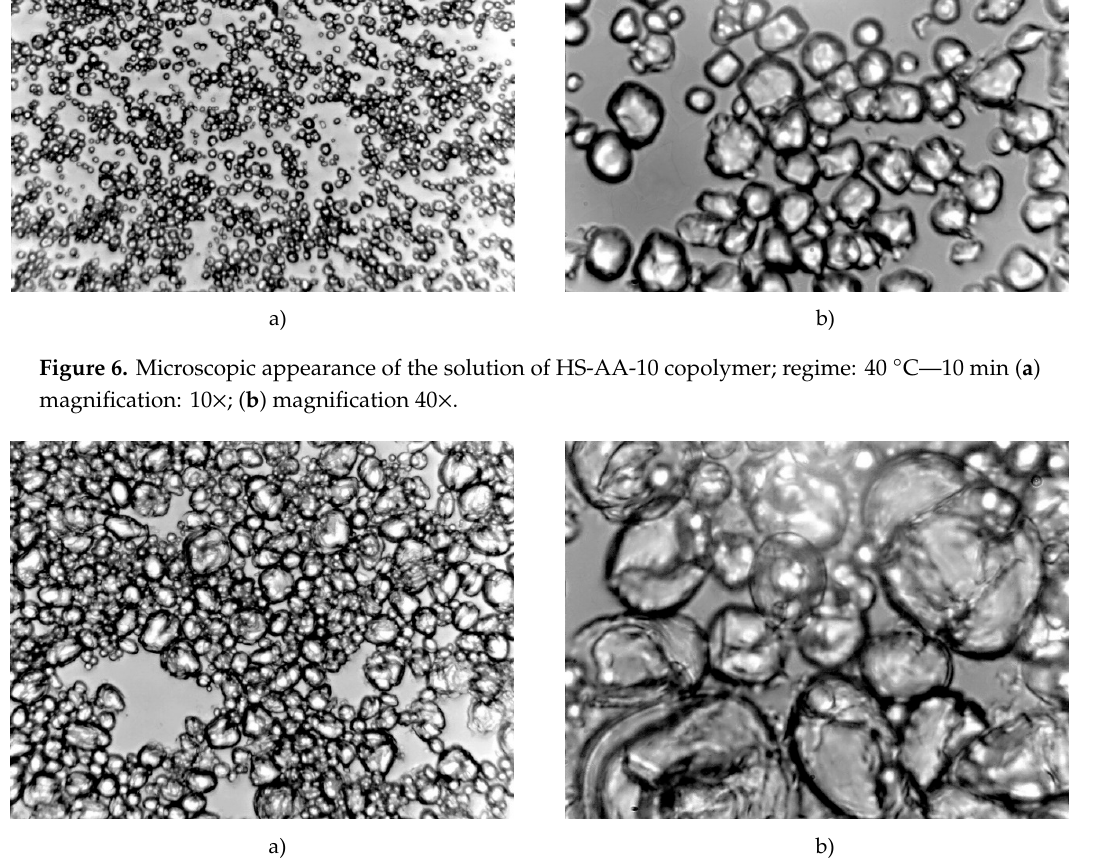
Figure 7. Microscopic appearance of the solution of HS-AA-10 copolymer; regime: 40 °C—60 min ( a ) magnification: 10×; ( b ) magnification 40×.